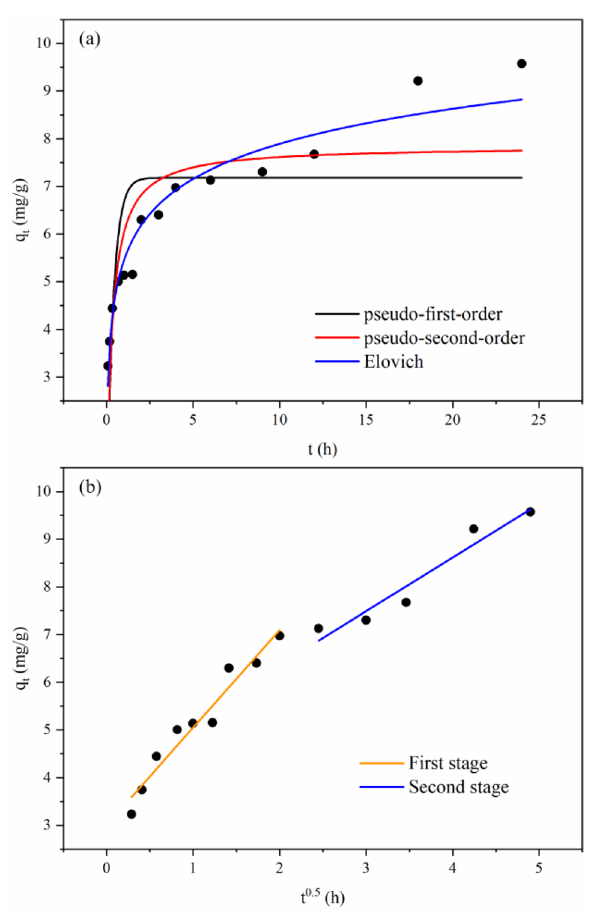
Figure 10. Fitting curves of the pseudo-first-order, pseudo-second-order and Elovich models ( a ) and intraparticle diffusion model ( b